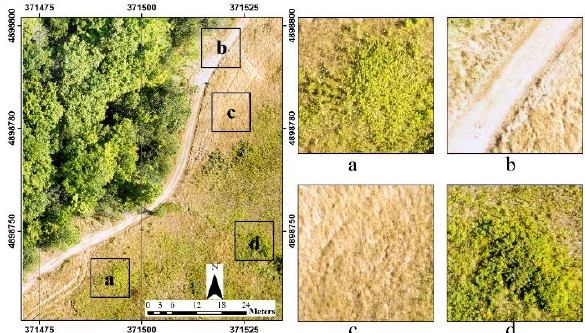
Figure 4 . UAV image of the tested subset with the enlarged areas with land cover types (a) Parsnip; (b) Road; (c) Grass; (d) Shrubs DSM is an elevation model with the top of surface objects such as buildings, vegetation, and other objects, whereas DEM represents the elevation of the bare earth without any